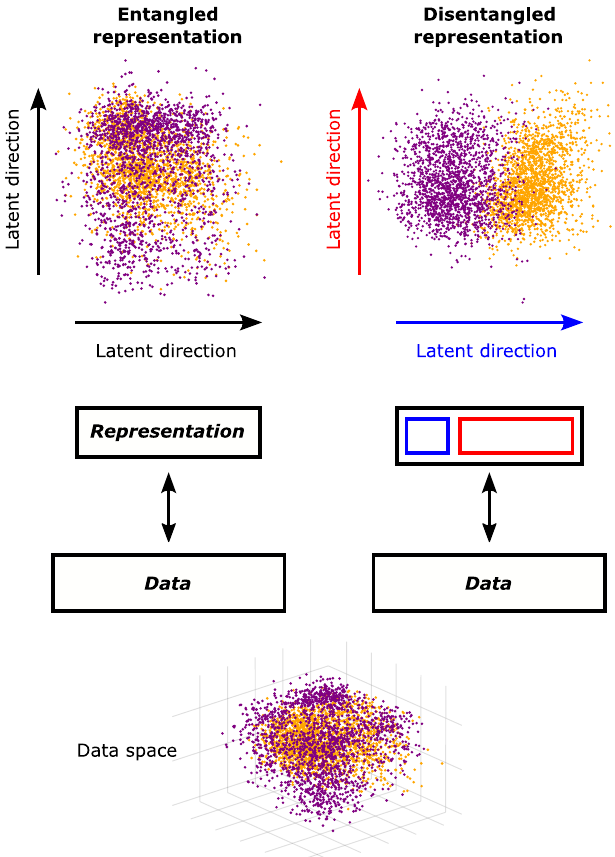
FIG. 1. Entangled vs disentangled representations. A set of high-dimensional data points (bottom) is mapped through un- supervised learning onto a latent representation (top). Data are colored in purple and orange according to a binary-valued attribute, e.g., being an odd or even number for MNIST images of handwritten digits. Left: When representations are entangled, the separation of data classes is not aligned with a single latent direction. Right: When representations are disentangled, one or few directions in latent space (blue) separate the labeled classes, while other directions are not correlated with the label